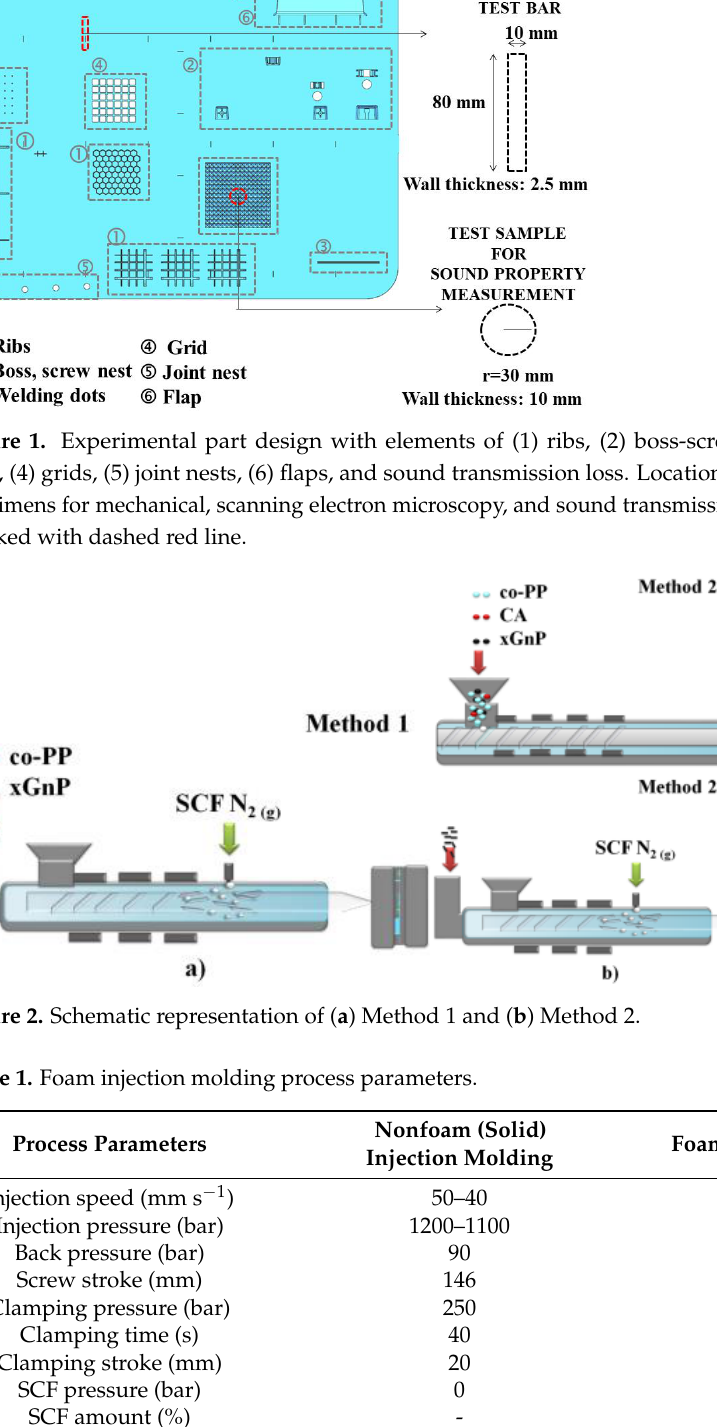
Figure 2. Schematic representation of ( a ) Method 1 and ( b ) Method 2.